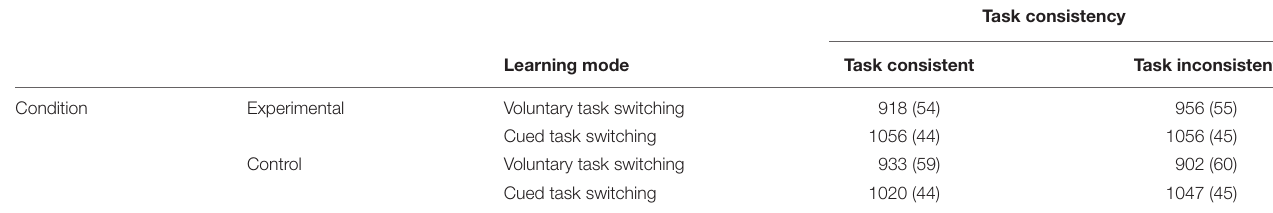
TABLE 3 | Mean RT (and SE) in ms in the test phase as a function of condition, learning mode and task consistency.